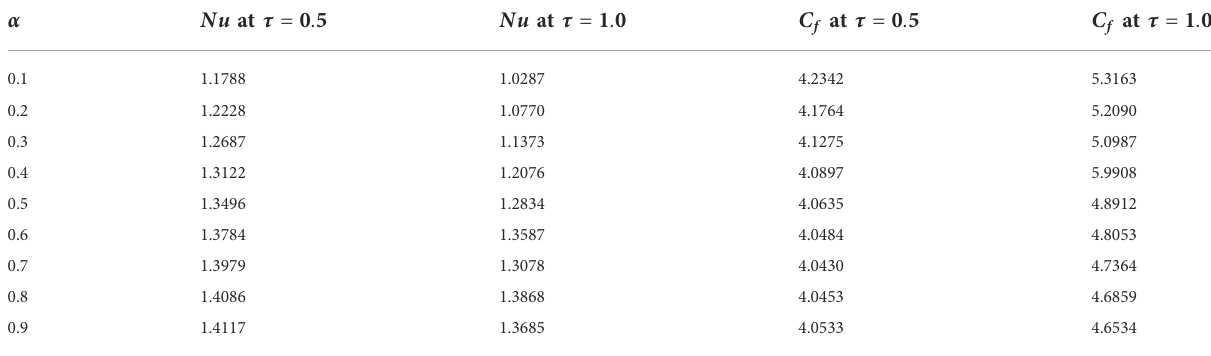
TABLE 3 Numerical analysis of the Nusselt number and skin friction. α Nu at τ (cid:3) 0 . 5 Nu at τ (cid:3) 1 .